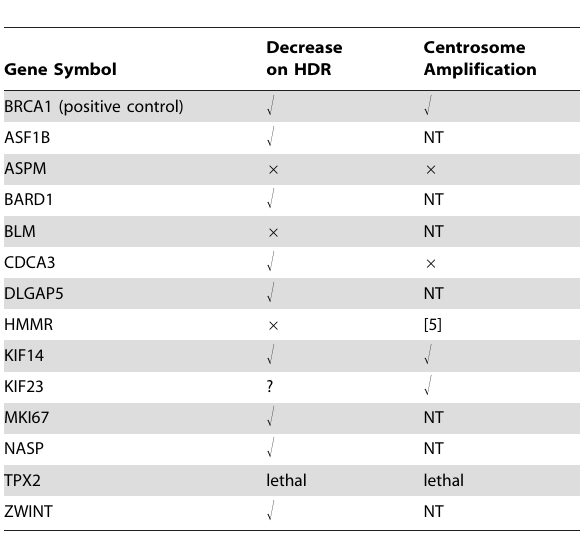
Table 4. Summary of effects on genome stability for genes depleted with siRNA using HR and centrosome assay on HeLa